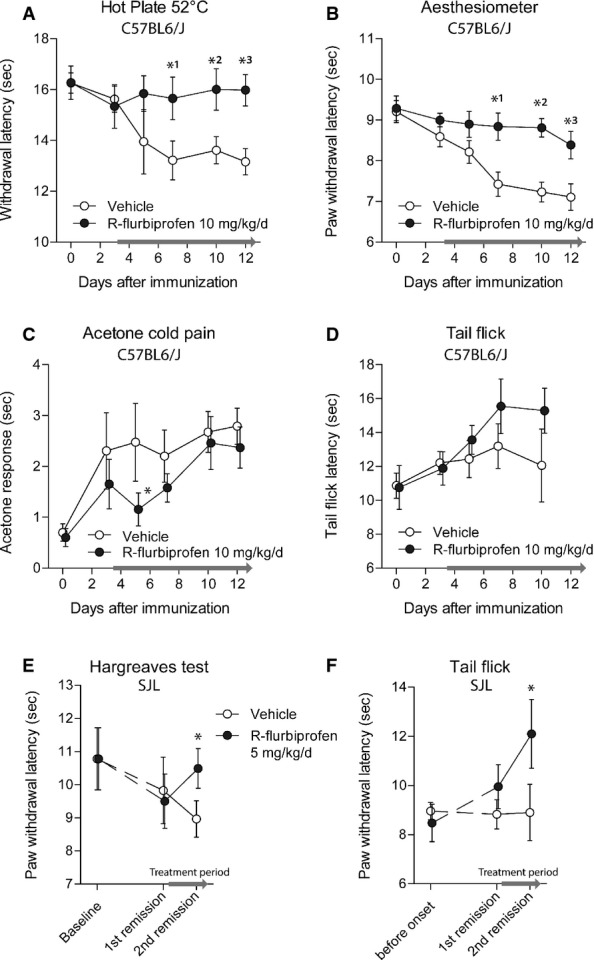
Reduction of EAE-evoked pain by R-flurbiprofenTime courses of the nociceptive behavior in the EAE model of multiple sclerosis in mice treated with vehicle or R-flurbiprofen, continuously administered via the drinking water. The treatment periods are indicated by a blue line on the x-axes. Data are the mean ± SEM. rm-ANOVAs revealed statistically significant differences between treatment groups, and asterisks indicate the time points, which differed significantly between groups.
Nociceptive sensitivity on heat stimulation in the hot plate test in C57BL6/J mice (n = 10, rm-ANOVA for ‘treatment’, P = 0.0107, post hoc P-values *10.045, *20.024, *30.003).Nociceptive sensitivity on mechanical stimulation in the Dynamic Plantar test in C57BL6/J mice (n = 10, rm-ANOVA for ‘treatment’, P = 0.0008, post hoc P-values *10.0034, *20.0008, *30.0142).Nociceptive sensitivity on cold stimulation in the acetone test in C57BL6/J mice (n = 10, rm-ANOVA, post hoc *P = 0.0354).Nociceptive sensitivity on heat stimulation in the tail flick test in C57BL6/J mice (n = 10).Nociceptive sensitivity on heat stimulation in the Hargreaves test in SJL mice (n = 6, unpaired two-sided Student's t-test for treatment period, *P = 0.048).Nociceptive sensitivity on heat stimulation in the tail flick test in SJL mice (n = 6, unpaired two-sided Student's t-test for treatment period, *P = 0.034).